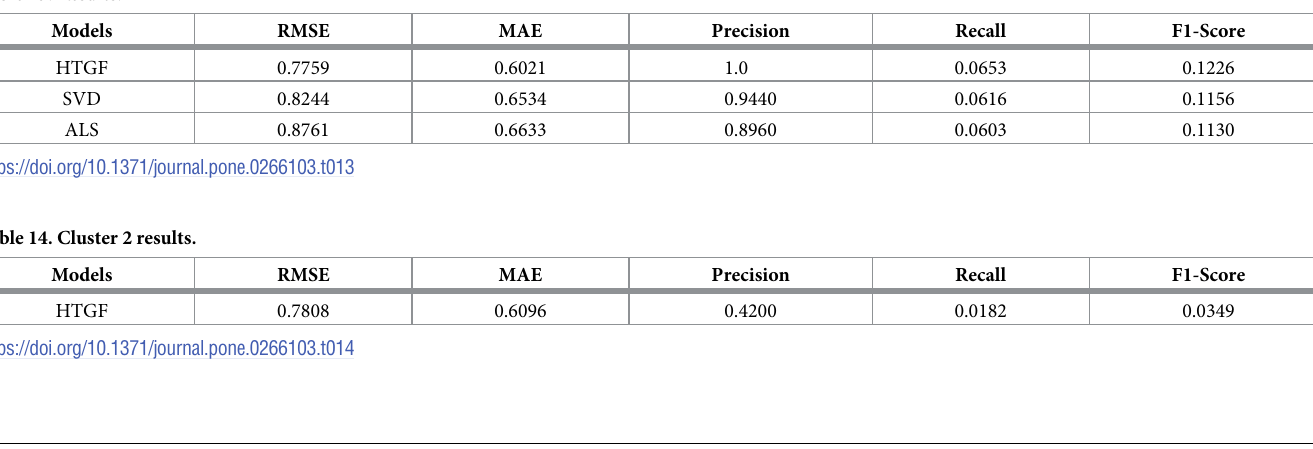
The efficiency of the proposed group recommender model is measured through group satisfac- tion metric. We split our dataset into 80 − 20, 80% ratings are used to train the model, and 20% ratings are used to evaluate the model. Performance of the proposed model was assessed by using RMSE, MAE, Recall, Precision, F1-Score, and group satisfaction measure. RMSE and MAE indicate the prediction accuracy of the model, while precision and recall are used to eval- uate the group recommendations generated by the model. We calculate the effect of group sat- isfaction by varying the group size. Table 13 provides the comparison with existing models. We used average aggregation strategy to aggregate the group members’ preferences. It is consensus-based strategy, and considers the preferences of all group members, unlike Most Pleasure strategy, which is a veto-based strategy. Lower values of RMSE and MAE indicate that the predicted ratings are close to the actual ratings. Higher the precision and recall means more relevant the recommendations are. We have also calculated the preferences of user for cluster 2, which is described in Table 14. It is observed that same user has different preferences in different groups. In Fig 4(a), the proposed model is compared with the existing approaches based on RMSE. The RMSE of ALS and SVD is 0.8761 and 0.8244, respectively, and of HTGF is 0.7759. Lower RMSE means the model’s predicted ratings are close to the actual ratings. Whereas, in Fig 4(b) the comparison is based on MAE, which is for ALS and SVD is 0.6633 and 0.6534, respectively, and the MAE of HTGF is 0.6021. Lower MAE means higher the accuracy of model. In Fig 5(a), the comparison is based on Precision, which is 0.8960, 0.9440, and 1.0 for ALS, SVD, and HTGF, respectively. The comparison based on recall is described in Fig 5(b). The values of recall for ALS, SVD, and HTGF are 0.0603, 0.0616, and 0.0653, respectively. Higher